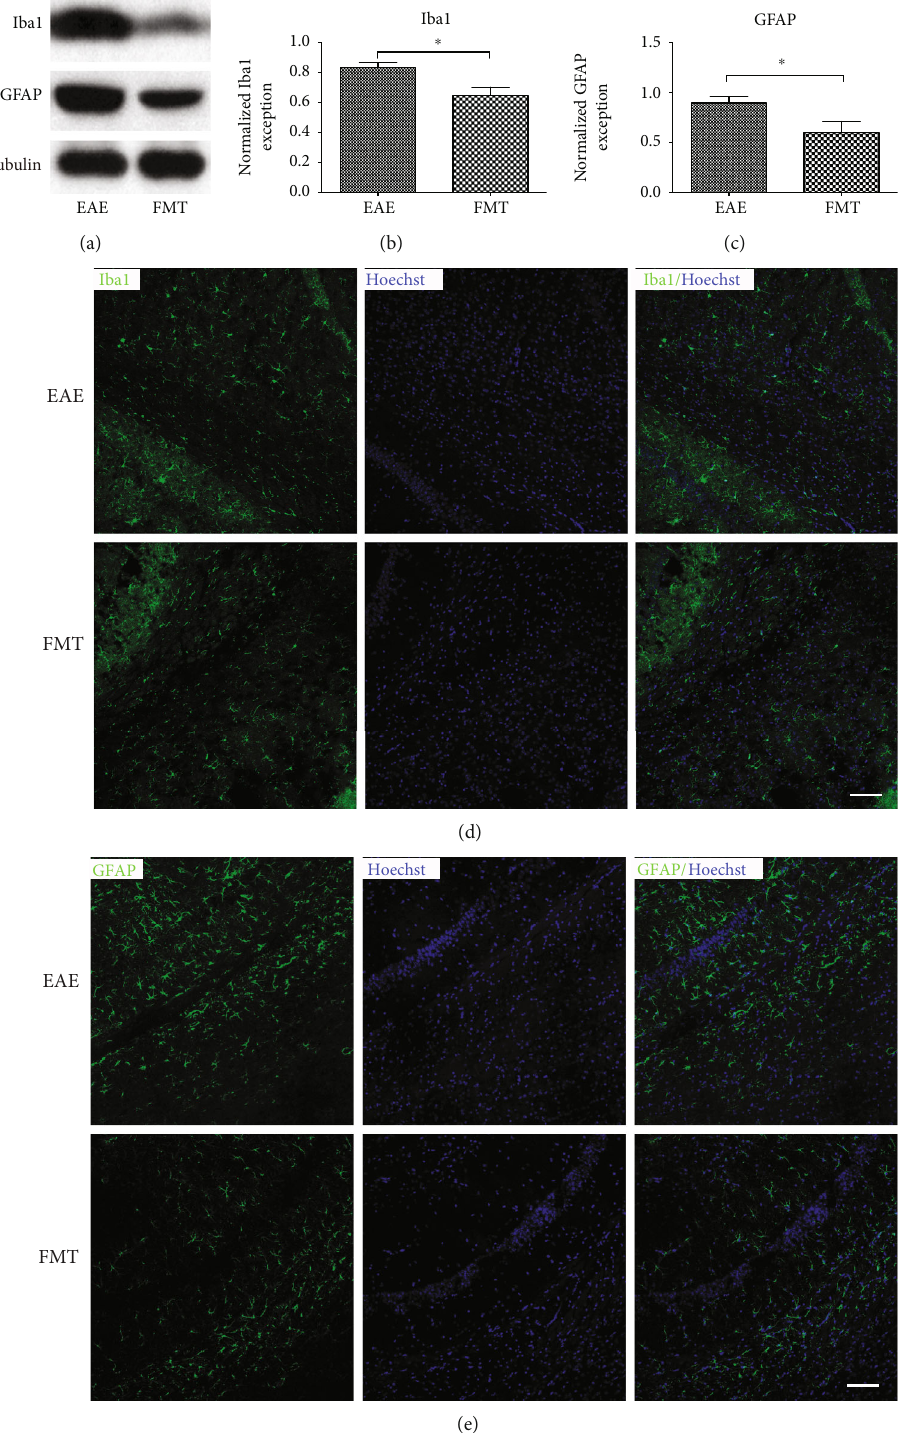
Figure 5: FMT alleviates immune cells and astrocyte activation in EAE. (a). Expression of Iba1 and GFAP protein in the brain of EAE controls and FMT-treated EAE mice shown by Western blot with β -tubulin as loading control. (b, c). Charts of quanti fi ed Western blot results indicating reduced levels of Iba1(b) and GFAP (c) expression (normalized by β -tubulin) after FMT treatment ( mean ± SEM ; n = 6 /group; ∗ p < 0 : 05 ). (d, e) Immuno fl uorescence imaging of cells expressing Iba1 (green; d) and GFAP (green; e) in brain sections with the nucleus stained by Hoechst (blue). Scale bar: 100 μ